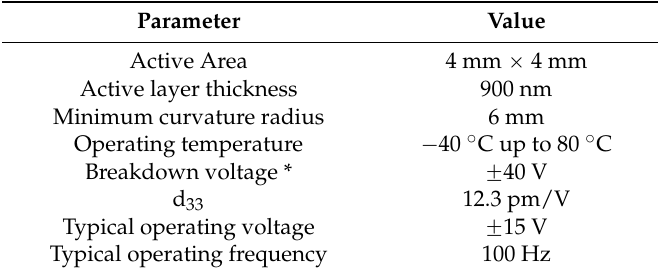
Table 3. Technical characteristics of the PPT